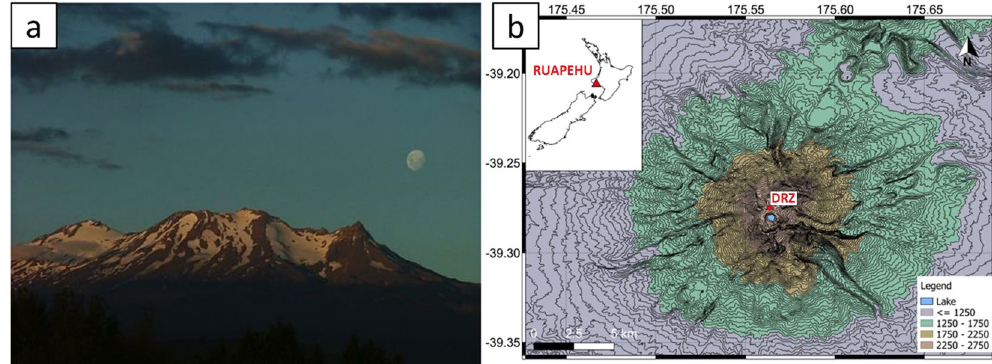
Figure 1. Ruapehu volcano. ( a ) Photo of Mt Ruapehu with the Moon in the background; by courtesy of Greg Steenbeeke. ( b) Location of Mt Ruapehu and the GeoNet seismic station (DRZ) used in this study. This map was generated with QGIS 2.16.1 (http://www.qgis.org/en/site/), contour lines were extracted from the ASTER Global Digital Elevation Model (GDEM) (ASTER GDEM is a product of NASA and METI;